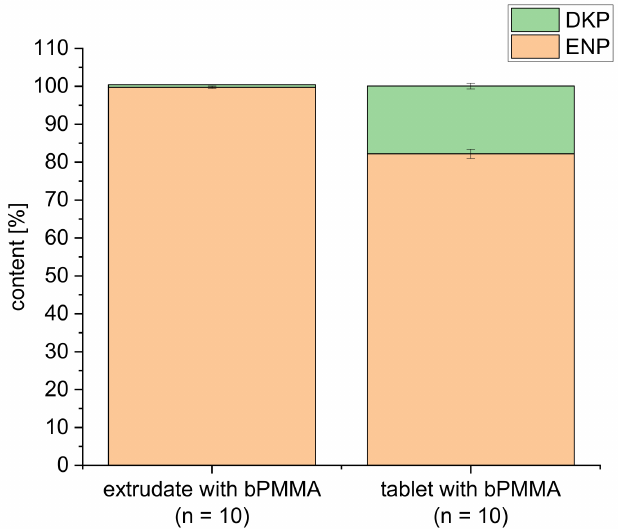
Figure 7. Illustration of the enalapril and diketopiperazine derivative contents after extrusion and 3D printing for the formulation containing bPMMA extruded at 70 ◦ C and printed at 180 ◦ C (n = 10, mean ±